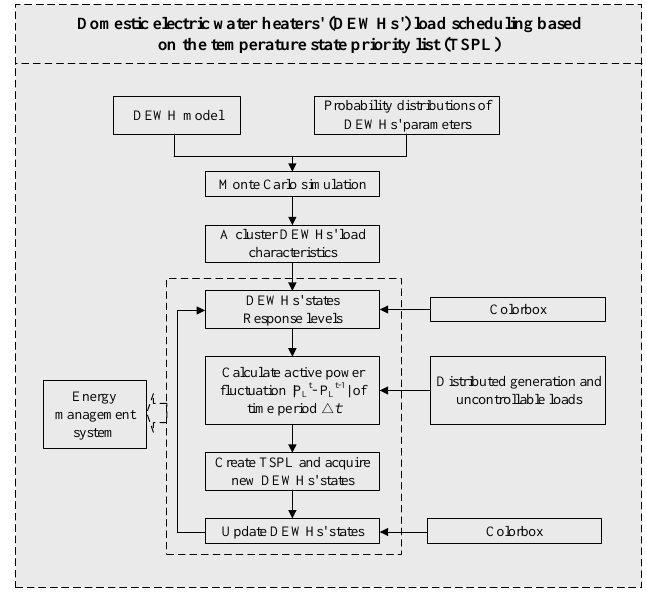
Figure 3. Domestic electric water heaters’ load scheduling strategy based on the temperature state priority list.